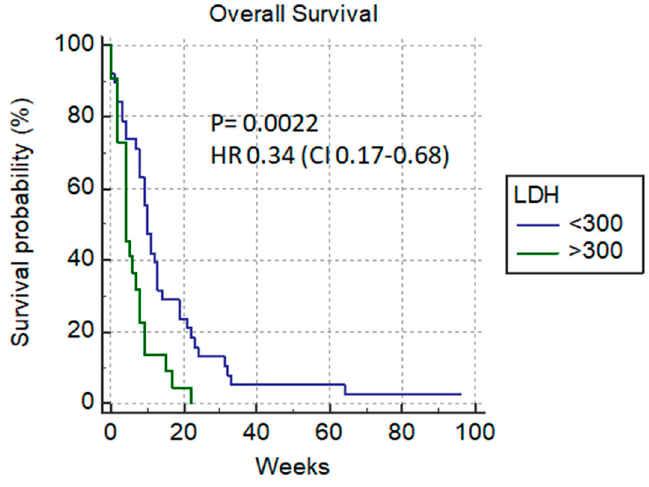
Figure 8. LDH level (<300 µmol/L vs. >300 µmol/L).